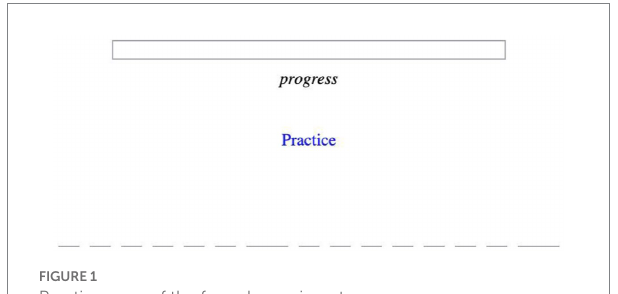
FIGURE 1 Practice page of the formal